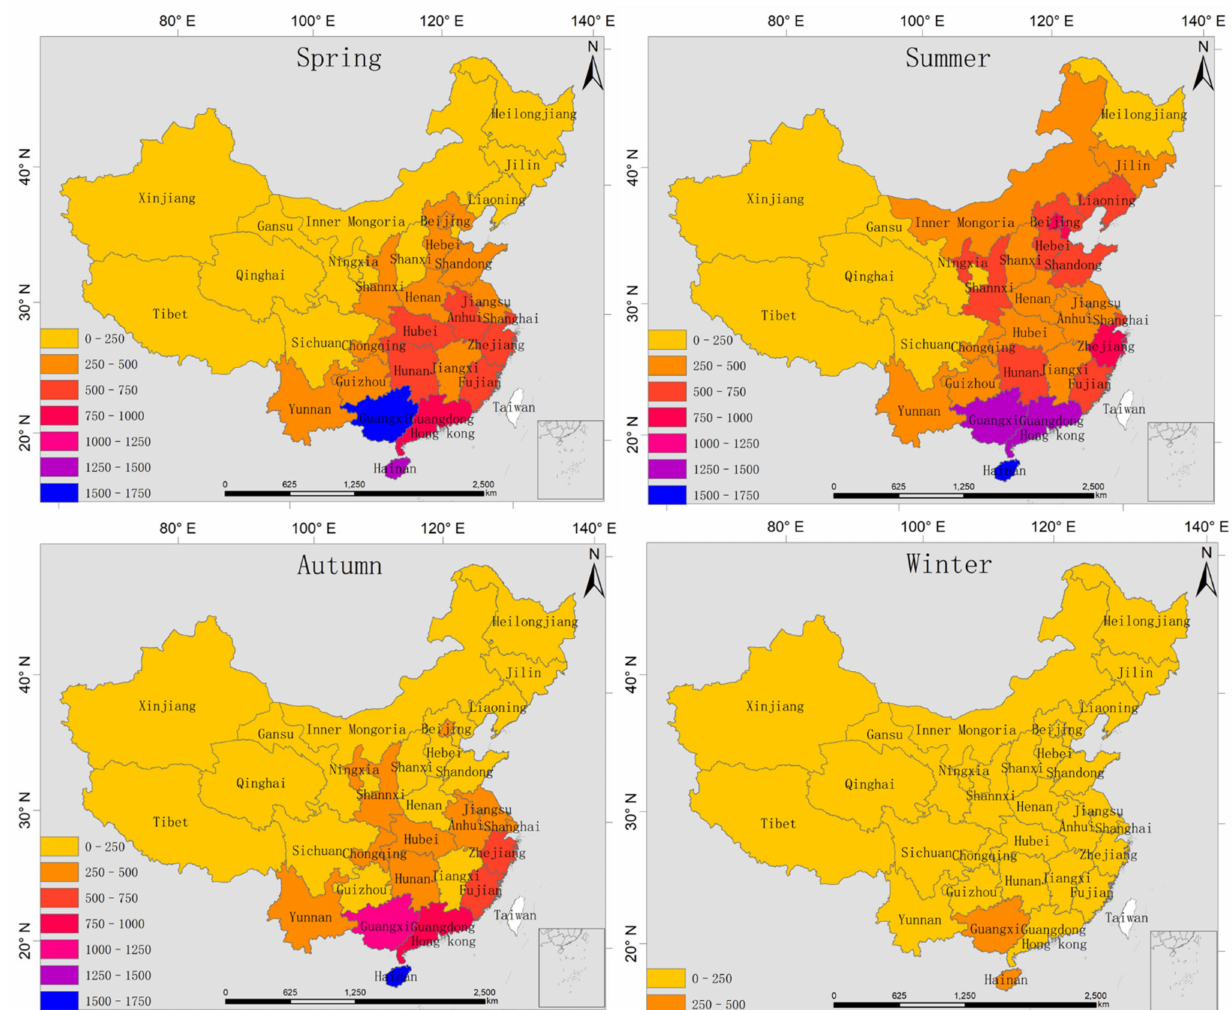
Figure 1. The seasonal distribution of cumulative incidence of hand, foot, and mouth disease (I-HFMD) on the Chin- ese